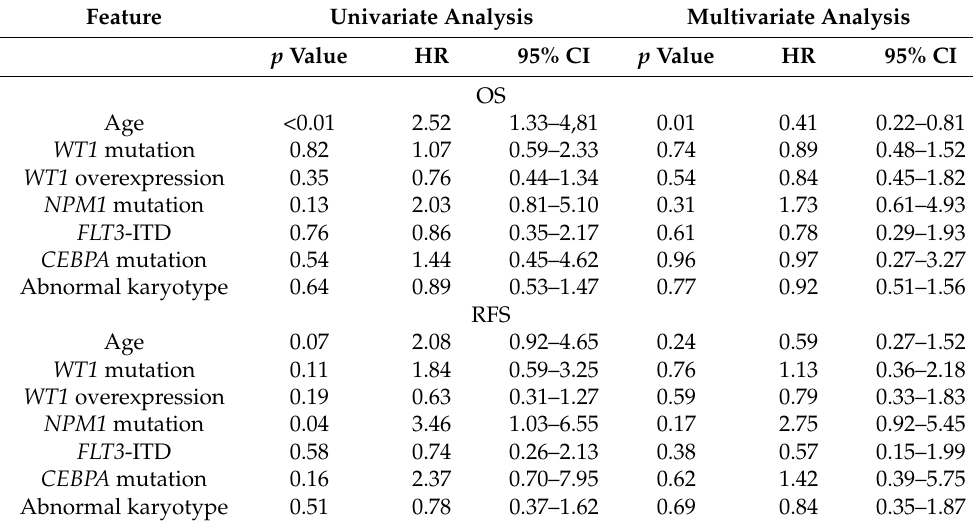
Table 5. Analysis of prognostic impact on OS and RFS in AML